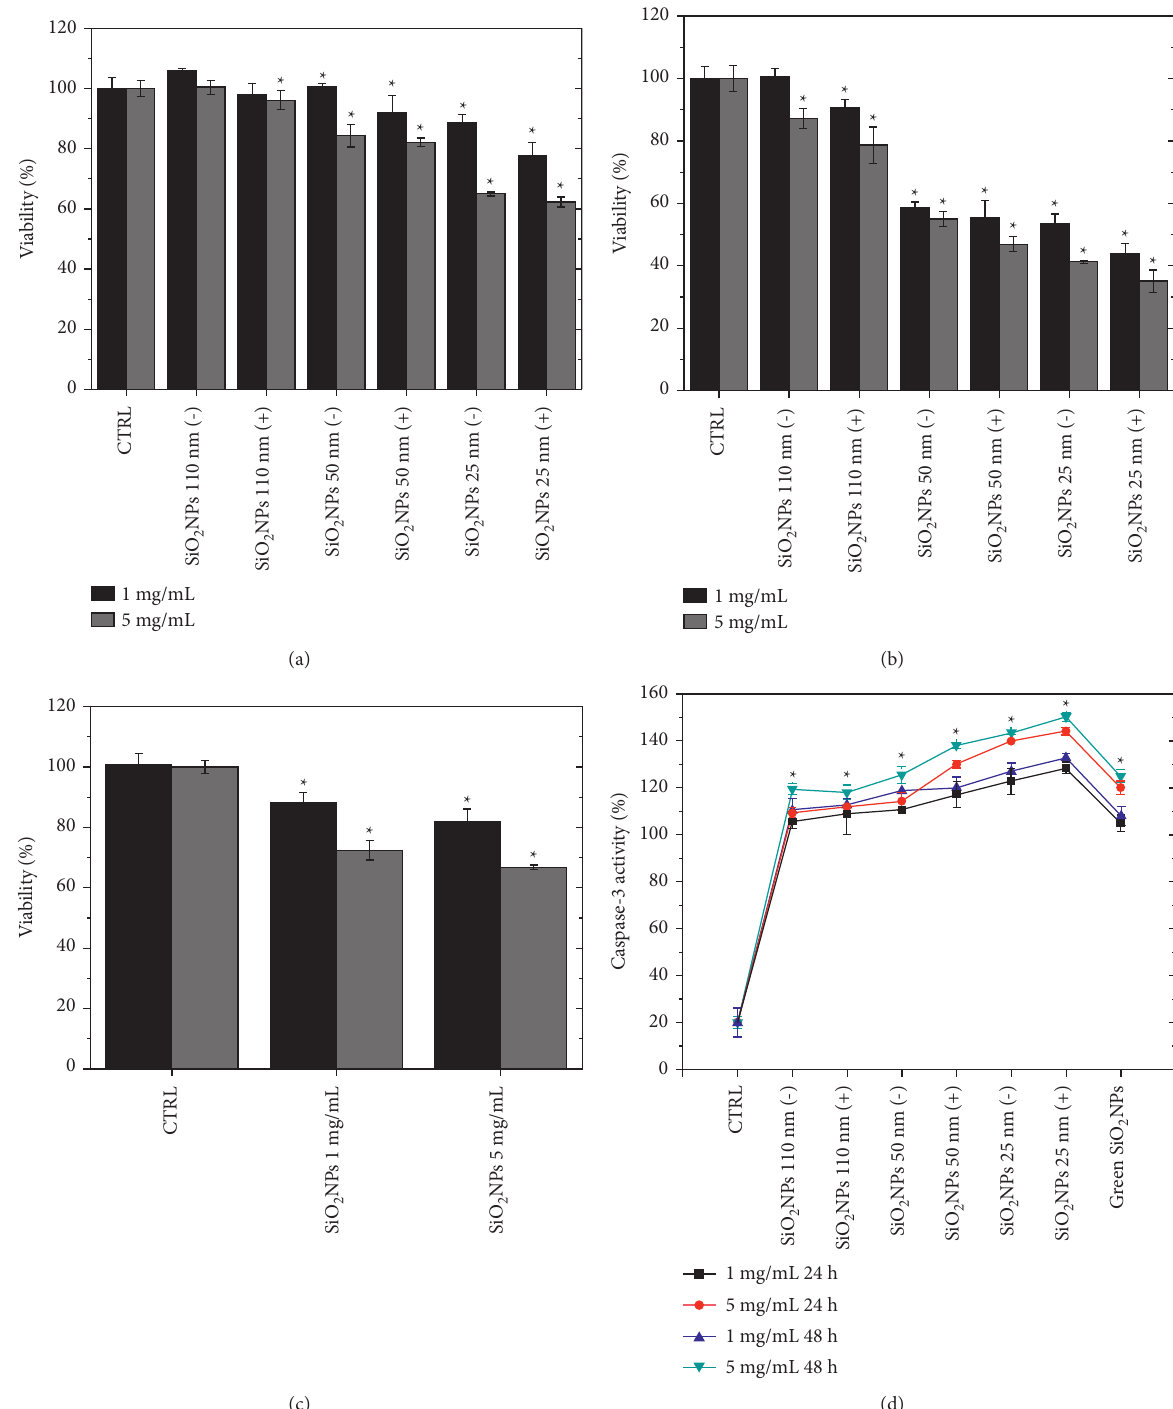
Figure 7: Viability assay (WST-8) of A549 cell lines after 24h (a) and 48 h (b) of exposure to 1 mg/mL and 5 mg/mL of SiO SiO 2 NPs 110nm (+), SiO 2 NPs 50nm ( − ), SiO 2 NPs 50nm (+), SiO 2 NPs 25 nm ( − ), and SiO 2 NPs 25nm (+). Viability assay (WST-8) of A549 cell lines after 24h and 48h of exposure to 1 mg/mL and 5 mg/mL of green SiO 2 NPs (c). The viability of NP-treated cells was normalized to nontreated control cells. As a positive control (P), the cells were exposed to 5% DMSO (data not shown). Data reported as the mean ± SD from three independent experiments are considered statistically significant, compared with the control ( n � 8) for p value < 0.05 ( < 0.05 ∗ ). Effect of SiO 2 NPs 110nm ( − ), SiO 2 NPs 110nm (+), SiO 2 NPs 50nm ( − ), SiO 2 NPs 50nm (+), SiO 2 NPs 25nm ( − ), SiO 2 NPs 25nm (+), and green SiO 2 NPs on levels of apoptosis (d). Caspase-3 assay was performed incubating A549cells with 1mg/mL and 5mg/mL of NPs for 24h and 48 (h). Data are reported as mean ± SD from three independent experiments; ∗ p < 0 . 05 compared with control ( n �